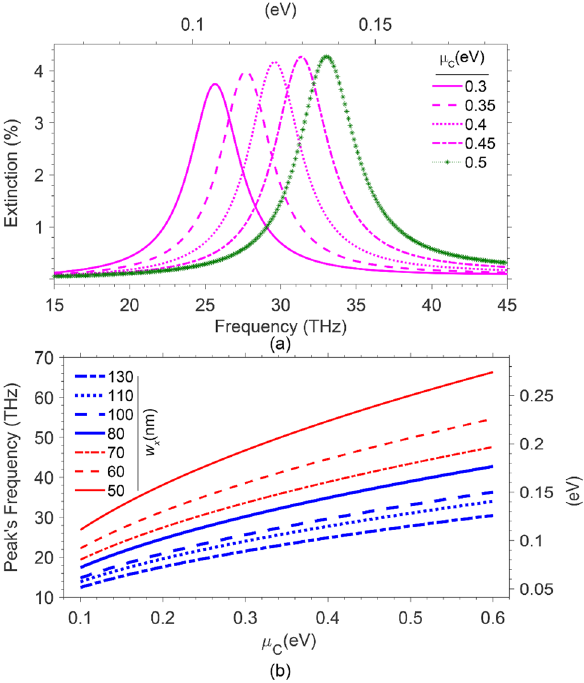
Figure 3. ( a ) Extinction spectra for the array of widths w x = 100 nm, at different chemical potentials, 0.3–0.5 eV. ( b ) The resonance frequencies versus μ C , for the arrays of widths w x = 50–130 nm.